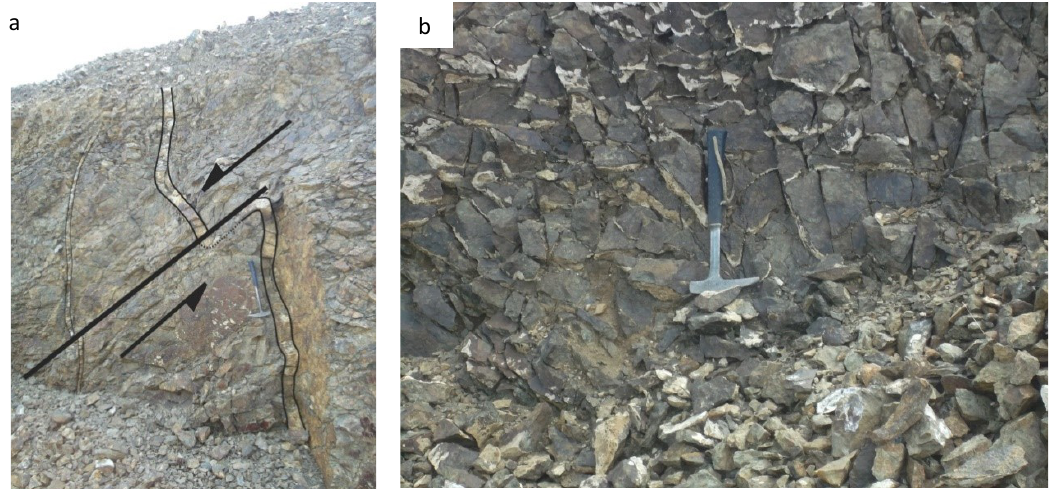
Figure 2. Transform fault of the brittle-ductile deformation of the quartz veins in the Burgetei exploration trench (a). Carbonate veinlets in the volcanites of the Burgetei occurrence trench (b) a